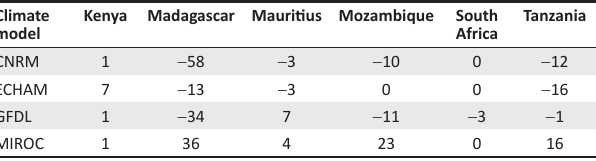
TABLE 4: Global hurricane damages caused by climate change in 2100.